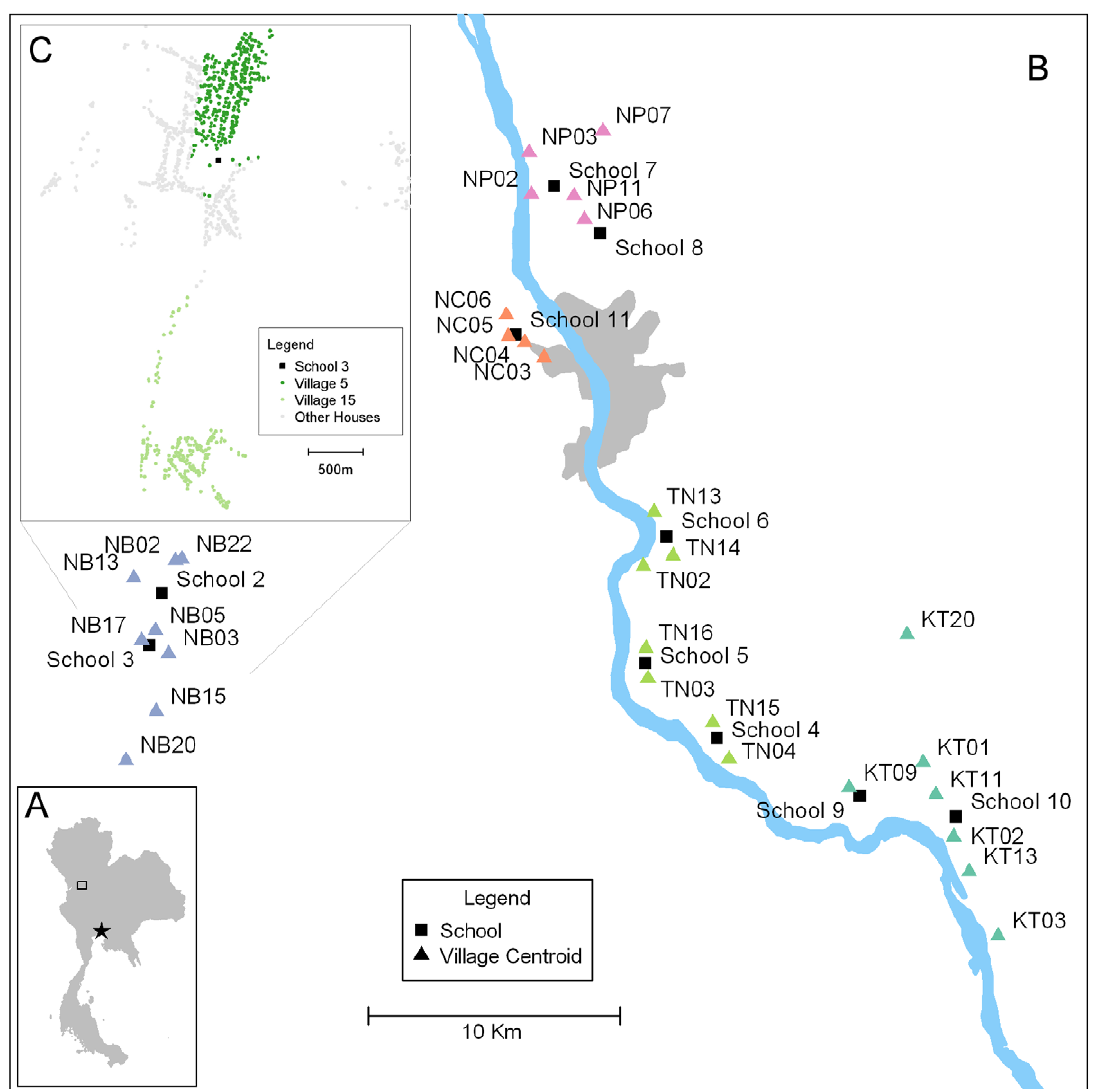
Figure 1. Study location map. A : Kamphaeng Phet (box), Thailand is located approximately 300 km Northwest of Bangkok (star). B : Map of study area in Muang District, Kamphaeng Phet, Thailand. The locations participating schools are indicated by black boxes and the villages that feed the schools are indicated with triangles. All houses within the villages in this study were GIS mapped, KT, Kon Tee; NB, Na Bo Kham; NC, Nakon Chum; NP, Nong Pling; TN, Thep Na Korn. C : A representational GIS mapping of two villages (5 and 15) to indicate the varying density of houses with the villages.